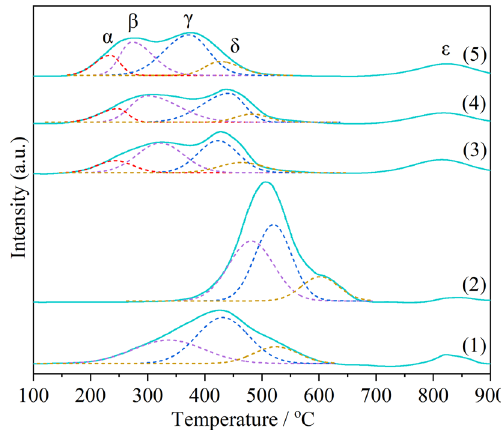
Figure 6. H 2 -TPR profiles of cerium manganese catalysts: (1) CM-Na; (2) CM-NaC; (3) CM-NC; (4) CM-N; (5) CM-3.